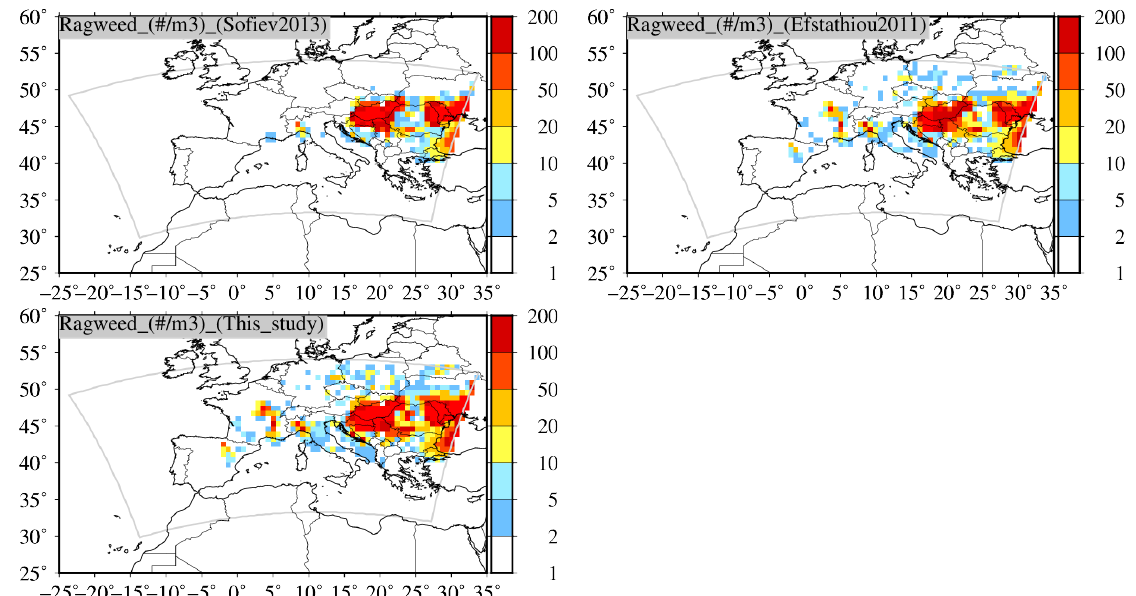
Figure 4. Maps of ragweed pollen surface concentrations for the 30 August 2010 at 12:00 UTC for the three studied schemes: P2013 (noted Sofiev2013 on the map), E2011 (noted Efstathiou2011 on the map) and TS2021 (noted This Study, on the